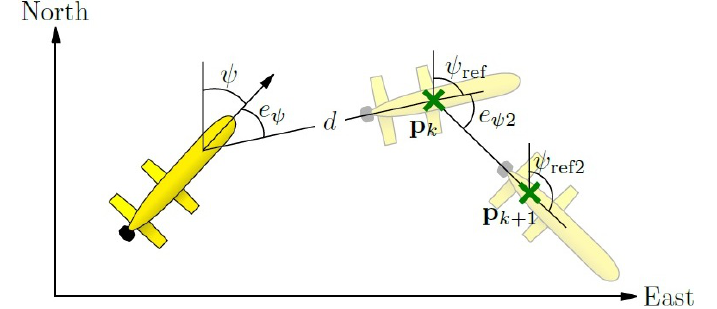
Figure 19. Pure pursuit: fuzzy